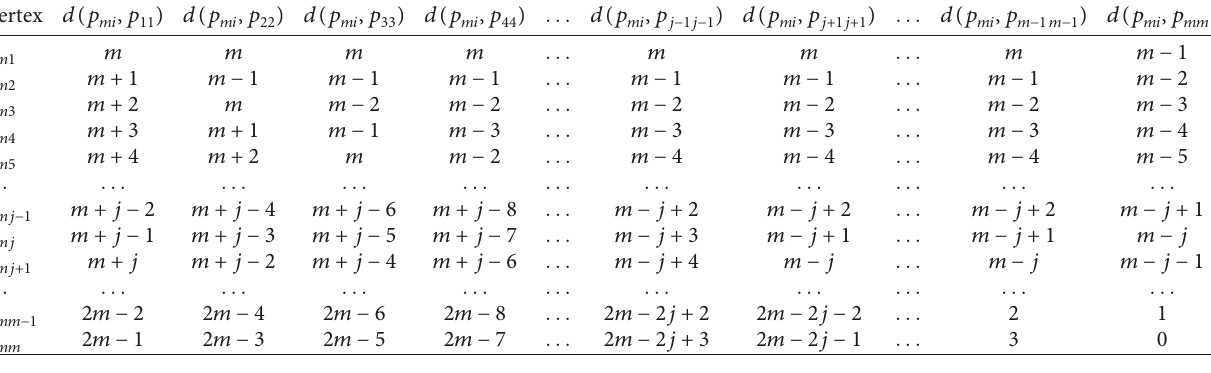
( M ) of vertices in the third cluster for 1 ≤ i ≤ m p mi jj